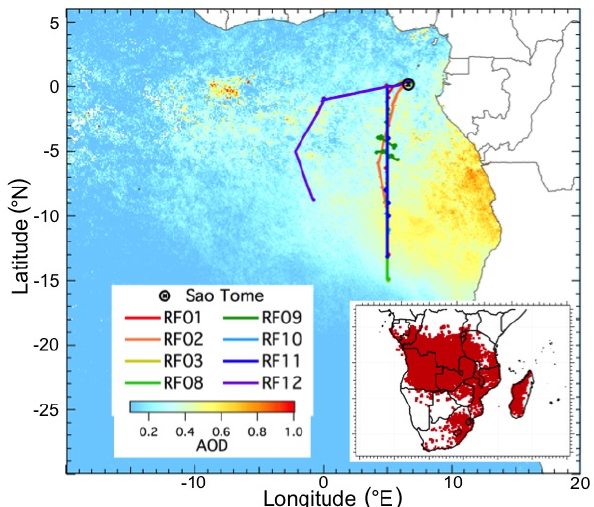
Figure 1. Map of ORACLES 2017 research flights used in this work, together with aerosol optical thickness (AOT) of the August 2017 plume (Meyer et al., 2015). The inset provides MODIS im- agery of savanna fires throughout August 2017. Most flights are in close proximity to the routine flight path of due south along a 5 ◦ E